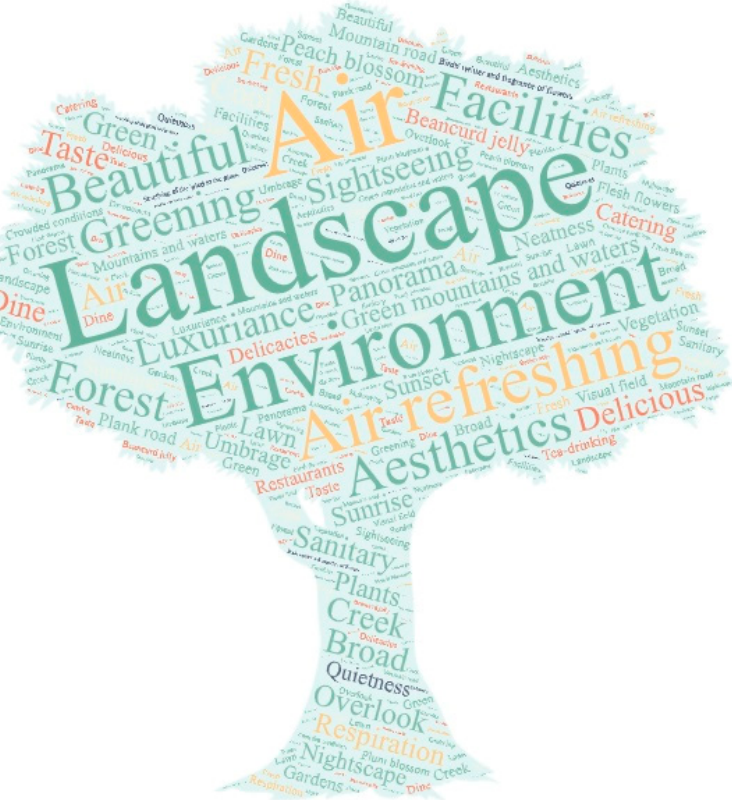
Figure 5. Word Cloud image of the high-frequency characteristic word.